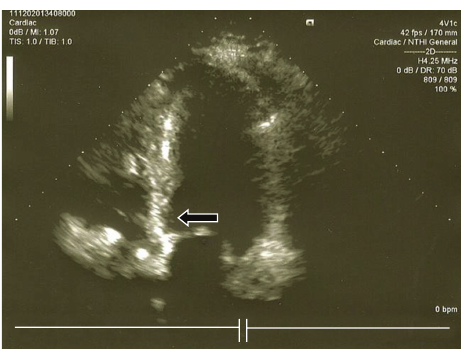
Figure 1: Control echo of patient N1 6 months after ASA. Thinning of basal septum is clearly visible